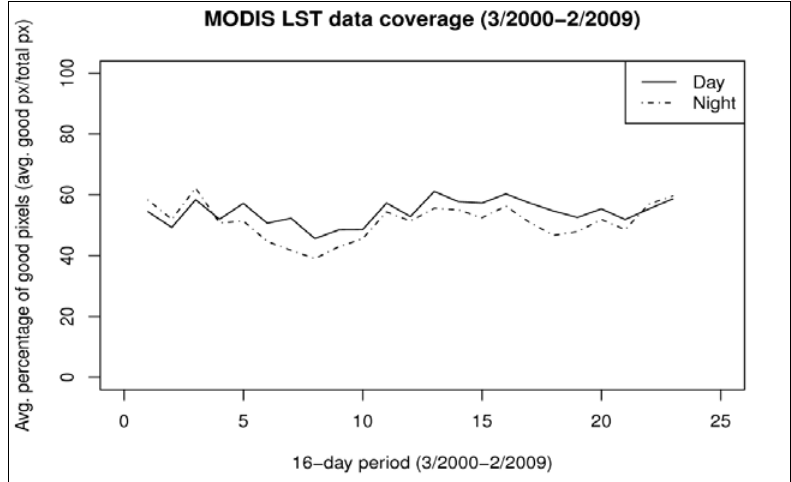
Figure 3. Average percentage of valid pixels in outlier filtered MODIS LST time series maps aggregated to 16-day periods (average good pixels/total pixels) separately for day and night overpasses. All available maps from 3/2000–2/2009 are included, with the exception of maps containing less than 10% valid pixels, based on 11,179 LST maps (spatial extent is the study region in Northern